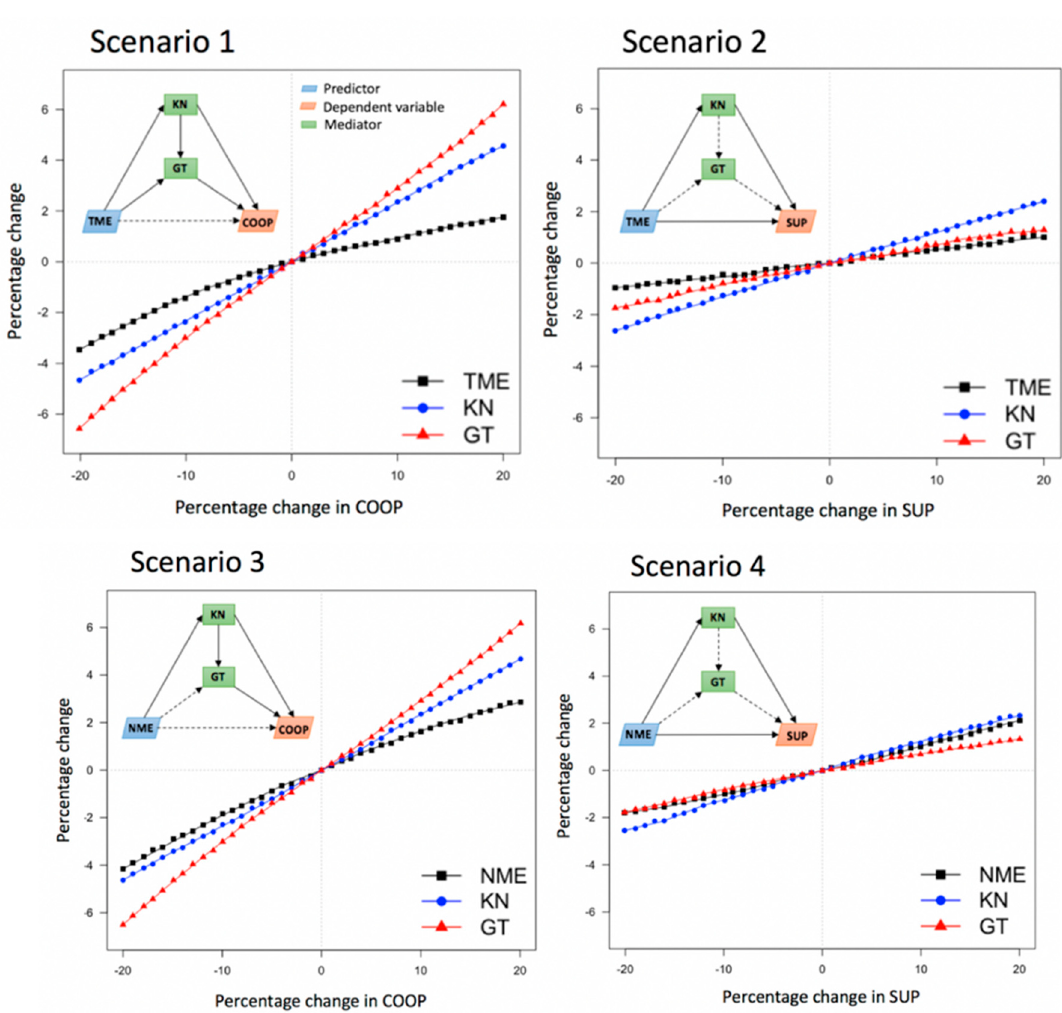
Figure 5. Mediating effects of four different scenarios. Percentage changes in each component, such as TME, NME, KN, and GT, were shown for the percentage changes in PHEP (COOP and SUP) from − 20% to +20% with 1% intervals using the Intentionally Biased Bootstrapping (IBB) model.